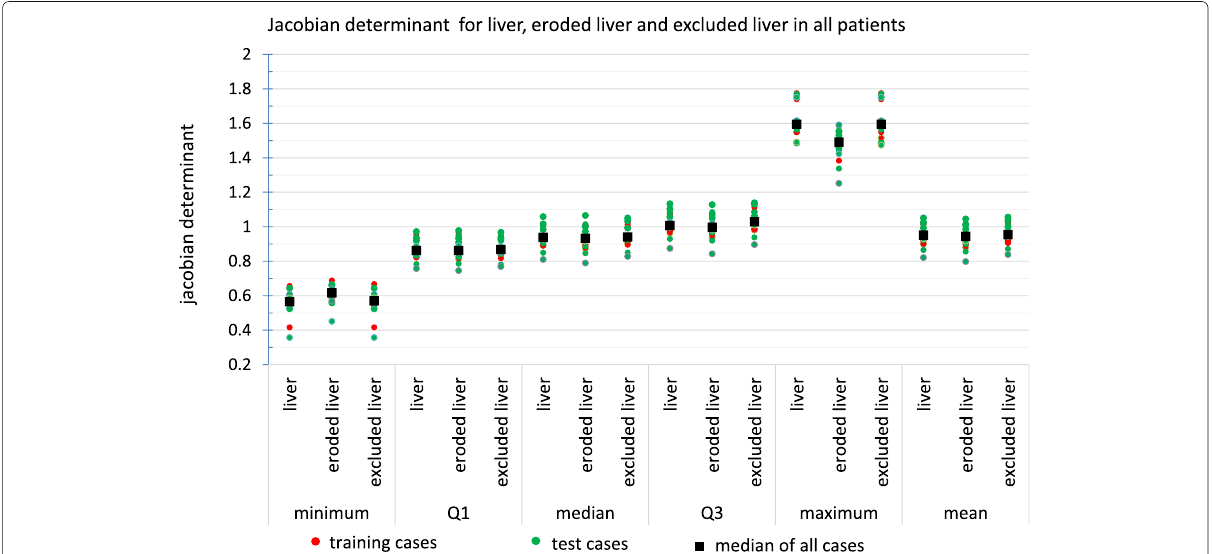
Fig. 9 First, second, and third interquartile range, minimum, maximum, and mean of for Jacobian determinant for the liver, eroded liver (liver eroded with 10 mm), and liver excluded (subtraction of eroded liver of liver), this measure shows the local dilation (Jacobian greater than 1), local contraction (Jacobian less than 1), and no local volume change (Jacobian 1) for each voxel for liver voxels, core of the liver, and border of the liver